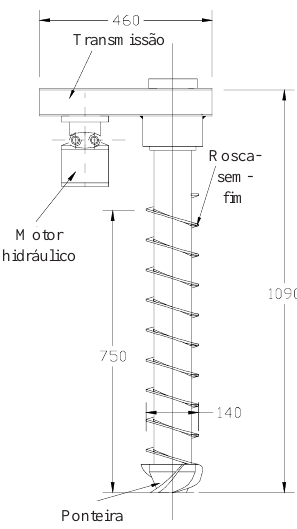
Figura 2. Amostrador de solos (dimensões em mm).